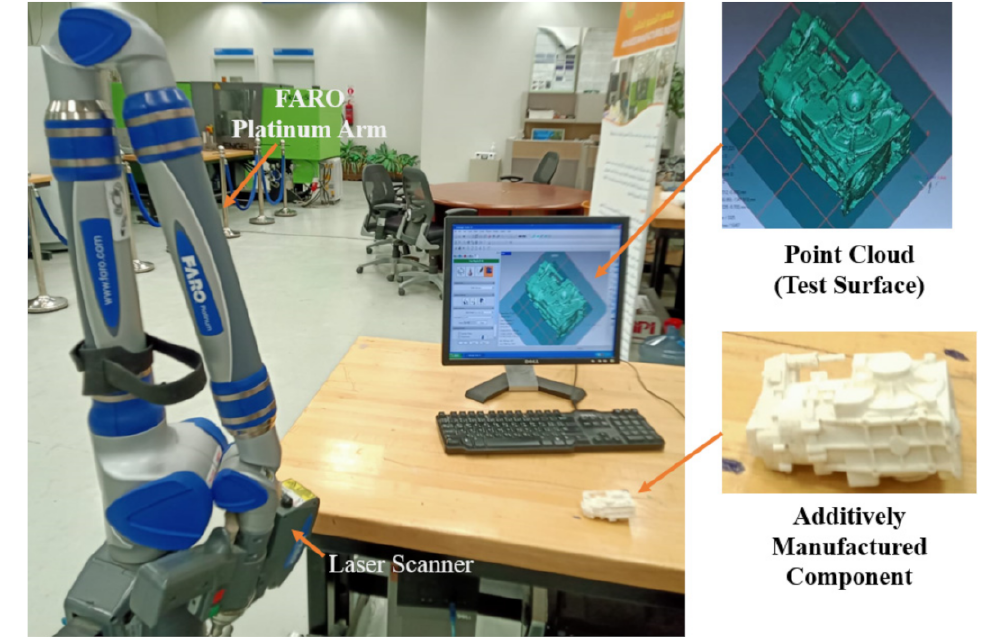
Figure 12. Set up to capture the shape of test